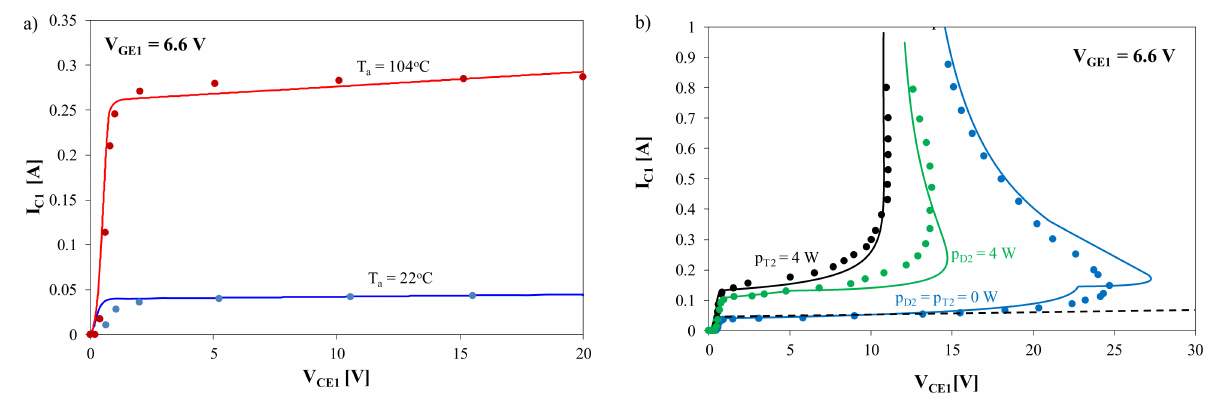
Figure 4. Computed and measured isothermal ( a ) and non-isothermal ( b ) output characteristics of transistor T 1 contained in the examined module at voltage V GE 1 = 6.6 V and different values of power dissipated in the other components of the